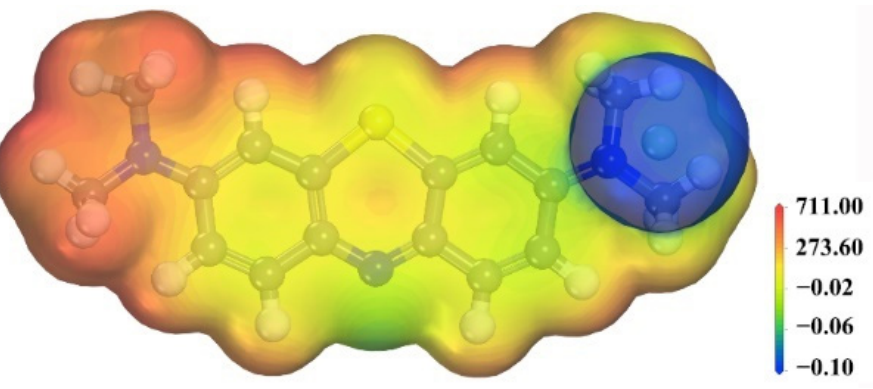
Figure 10. Molecular electrostatic potential diagram of MB.